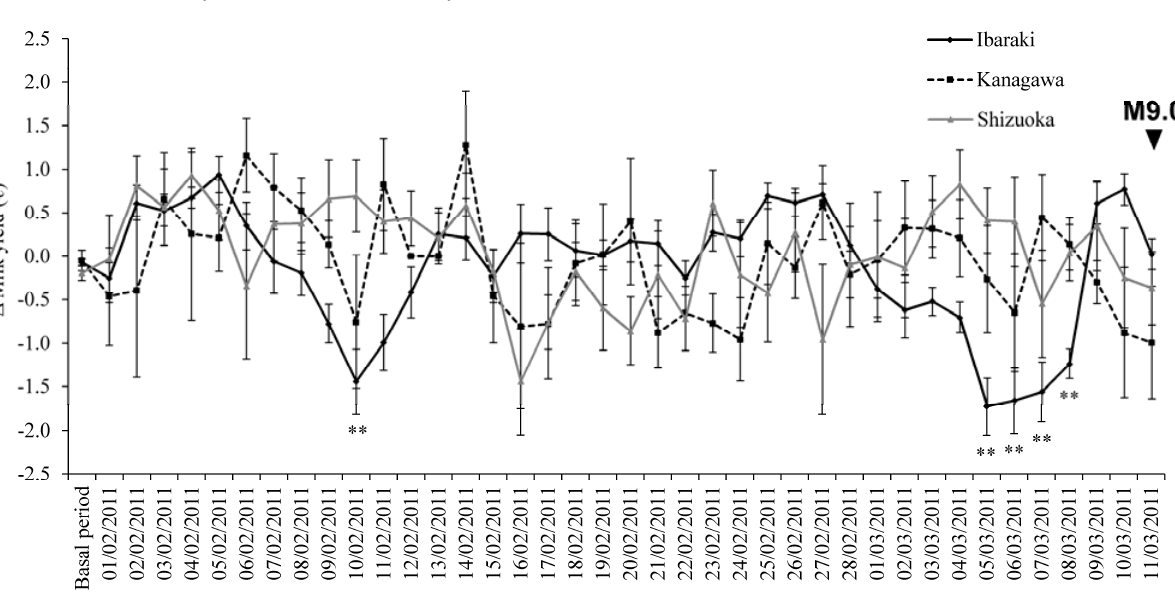
calving and environmental factors at three institutes in Japan from 1 January 2011, to 11 March 2011. Darkened triangle ( ▼ ) indicates the occurrence of the earthquake. A double asterisks denote a significant difference at P < 0.001 compared with milk yields from 1 January 2011, to 31 January 2011, at the same